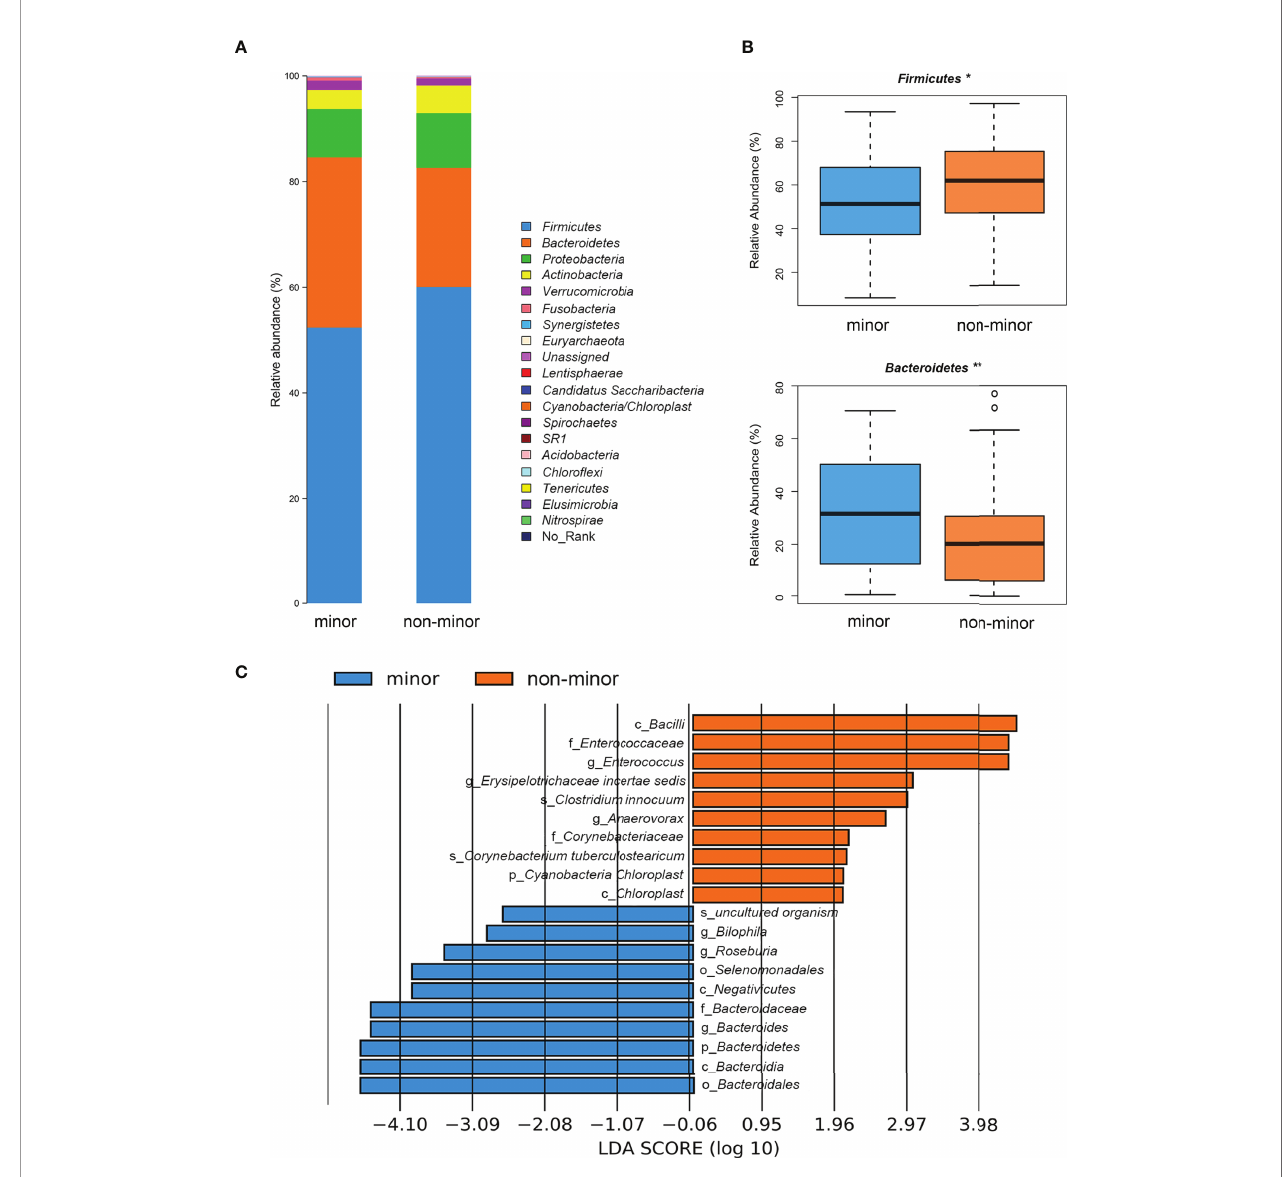
FIGURE 2 | Difference of microbialcomposition between minor strokepatients and non-minor stroke patients. (A) Taxonomicsummaryofthe gut microbiota ofminor strokepatients and non-minor stroke patients at the phylum level. (B) Bacteriawith signi fi cant differences between minor stroke patients (blue) and non-minor strokepatients (orange) at the phylum level (Metastats analysis).Boxes represent the interquartile ranges, lines inside the boxes denote medians, and circles are outliers. (C) Signi fi cantly discriminative taxa between the minor strokepatients (blue) andnon-minor strokepatients (orange) determined by linear discriminant analysiseffect size (LDAeffect size). *p < 0.05, **p <